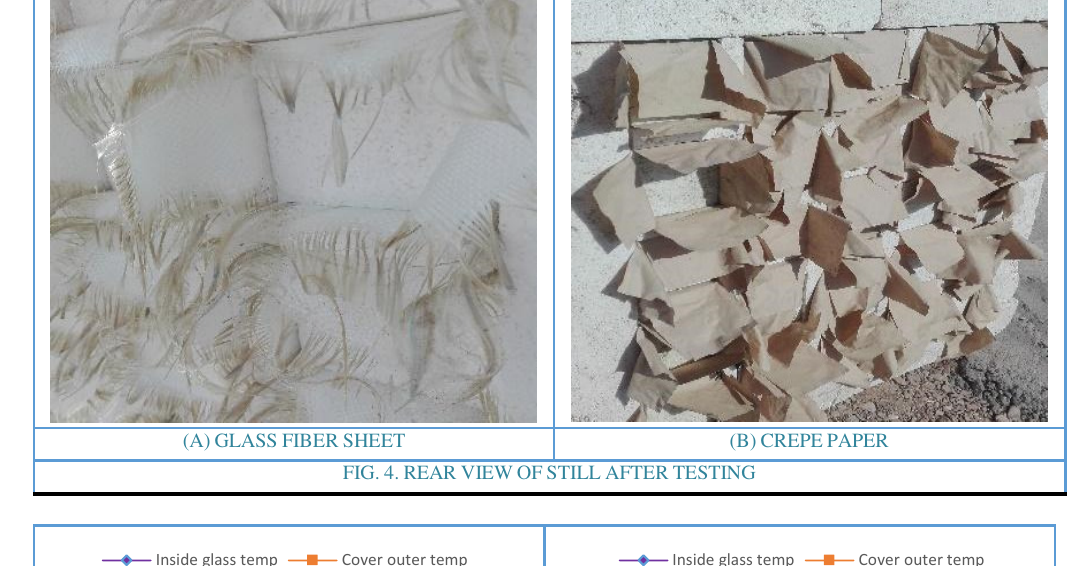
FIG. 4. REAR VIEW OF STILL AFTER TESTING